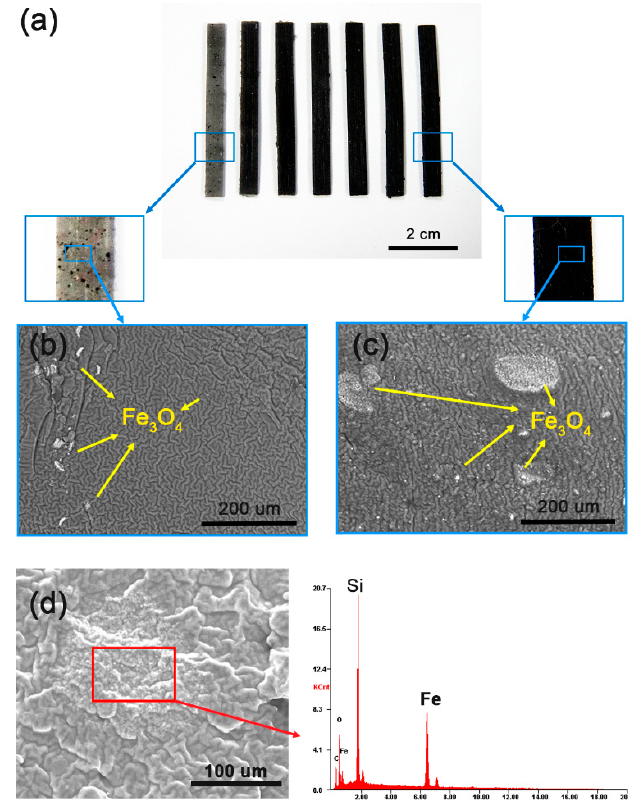
Figure 1. Characteristics of Fe 3 O 4 -silicone composite actuator depending on iron oxide concentration. ( a ) Fe 3 O 4 -silicone composite actuator beams with 1% to 20% iron oxide concentration (from left to right: 1%, 1.5%, 2%, 2.5%, 5%, 10%, and 20%). SEM images of Fe 3 O 4 -silicone composite actuators: ( b ) 1% and ( c ) 20%. The dark gray wrinkled structures represent silicone, while the bright dots represent iron oxide particles. ( d ) Microanalysis results show that the bright dots correspond to iron oxide.